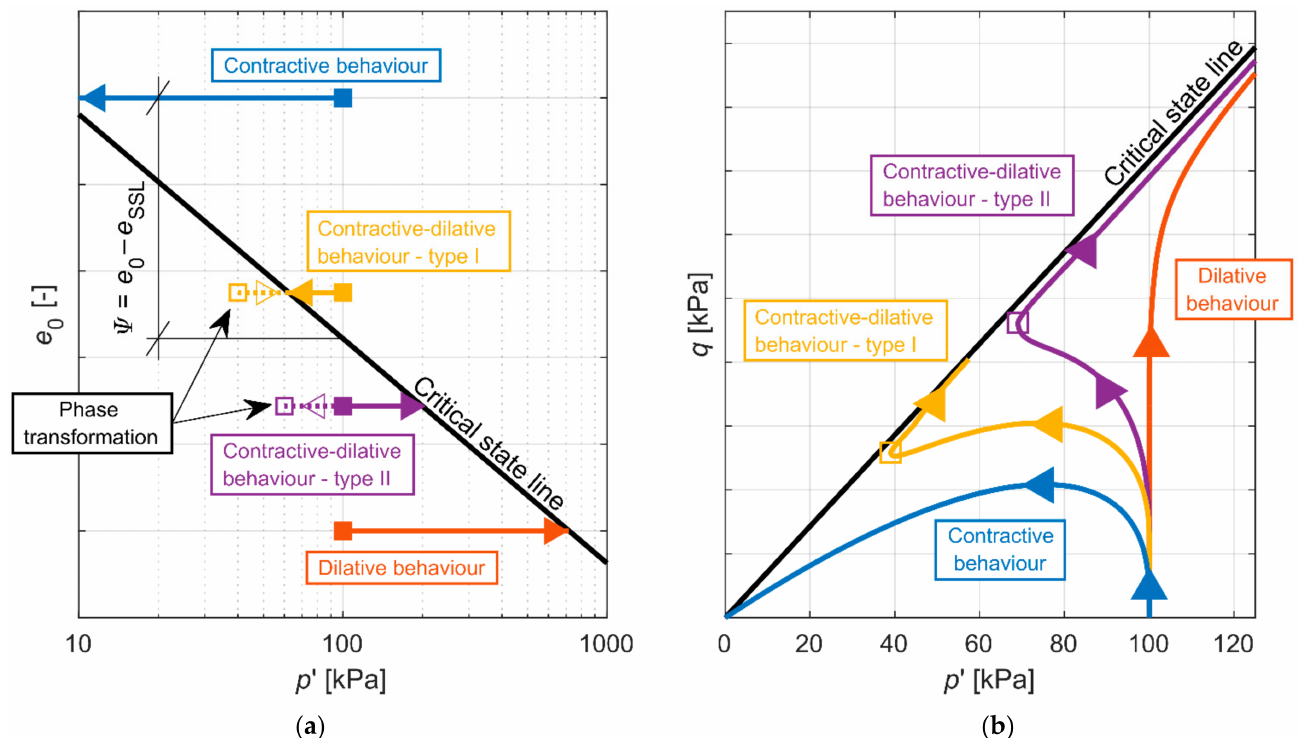
Figure 1. ( a ) Critical state line with definition of state parameter. ( b ) Typical responses of saturated soil during shearing under undrained